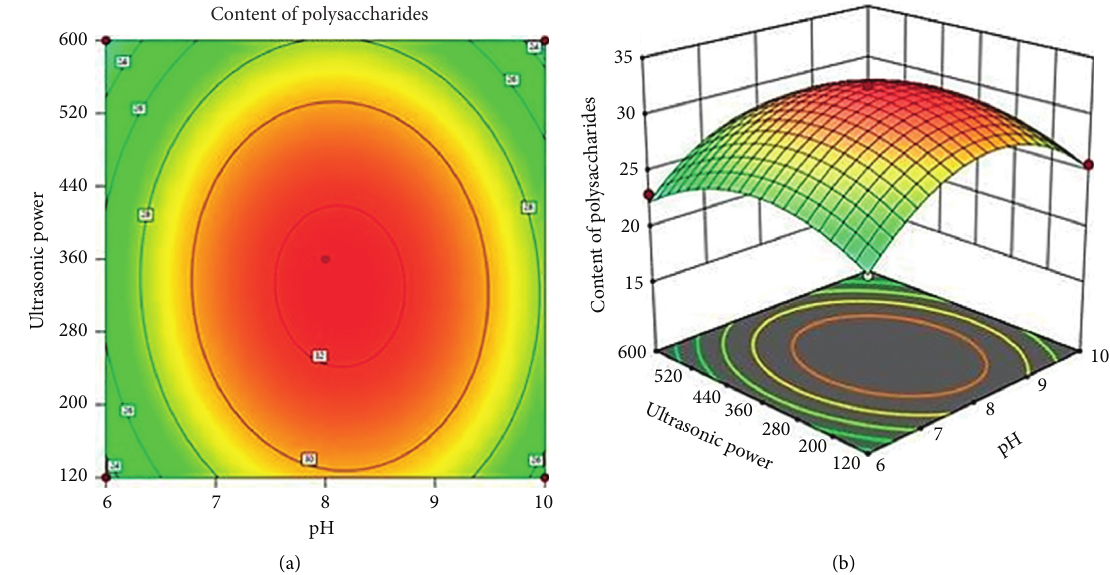
Figure 4: Simultaneous effect of pH and ultrasonic power on the content of polysaccharides.